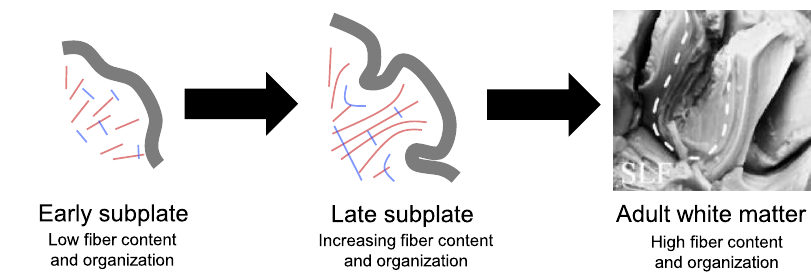
Fig. 1 Cortical folding and subcortical organization. a – b Magnetic resonance images of the fetal human brain at the onset of cortical folding ( a ) and after formation of cortical folds ( b ). Images generated from template described in Gholipour et al. 69 . c Mechanisms proposed to actively induce cortical folding include axon tension that preferentially tethers speci fi c areas of cortex (top), subplate growth that exerts an outward push to form gyri (middle), and constrained cortical growth, either uniform or patterned, that induces mechanical buckling (bottom). d Schematic illustration of previously reported observations in the developing subplate, including steady increase in axon density during the period of folding and emergence of organization mirroring adult white matter. Image of human brain from Burks et al. 41 illustrates predominant organization observed in the adult white matter, including radial organization beneath gyri and tangential organization beneath sulci. Dotted line indicates short association fi bers bridging adjacent gyri (U- fi bers), SLF = superior longitudinal